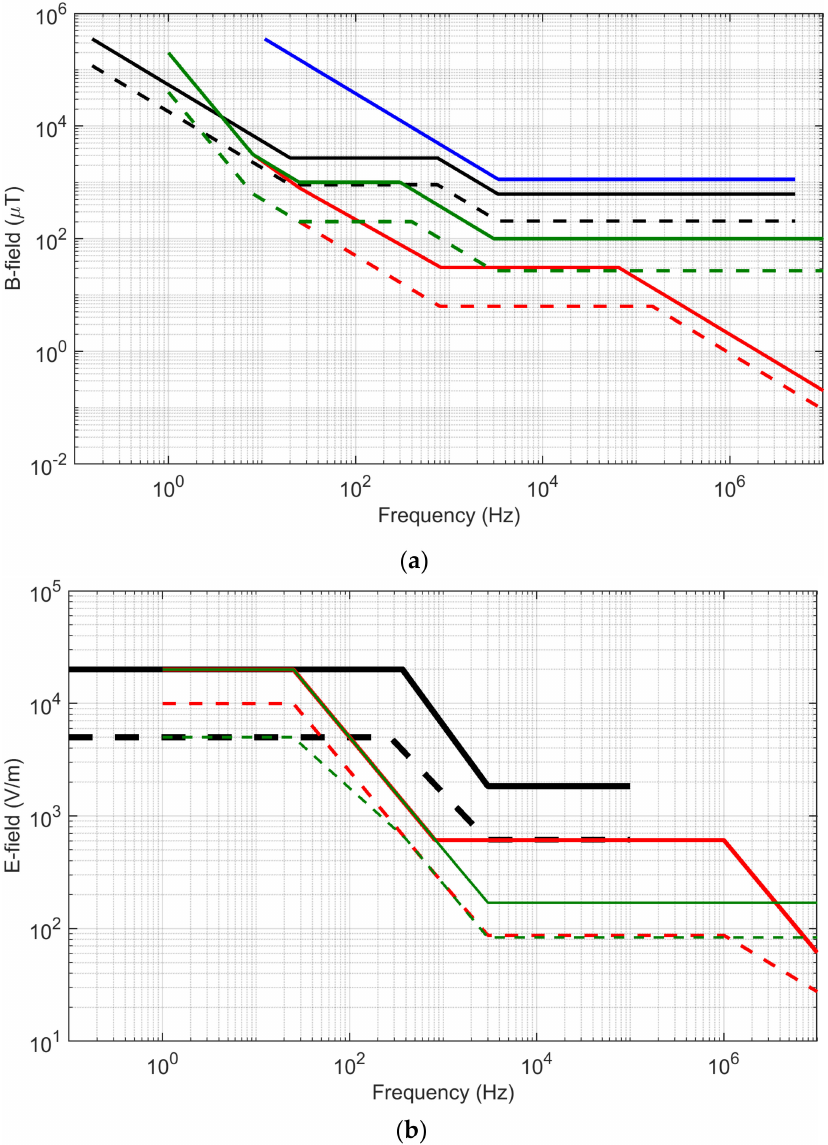
Figure 3. Reference levels for ( a ) B-field and ( b ) E-field (rms value): ICNIRP 1998 [1] (red), ICNIRP 2010 [3] (green), IEEE C95.1 2019 [39] (black, head, and torso for B-field, whole body for E-field; blue, limbs for B-field). Solid lines are for occupational exposure and dashed lines for general public exposure (for the IEEE C95.1 limbs exposure the two are